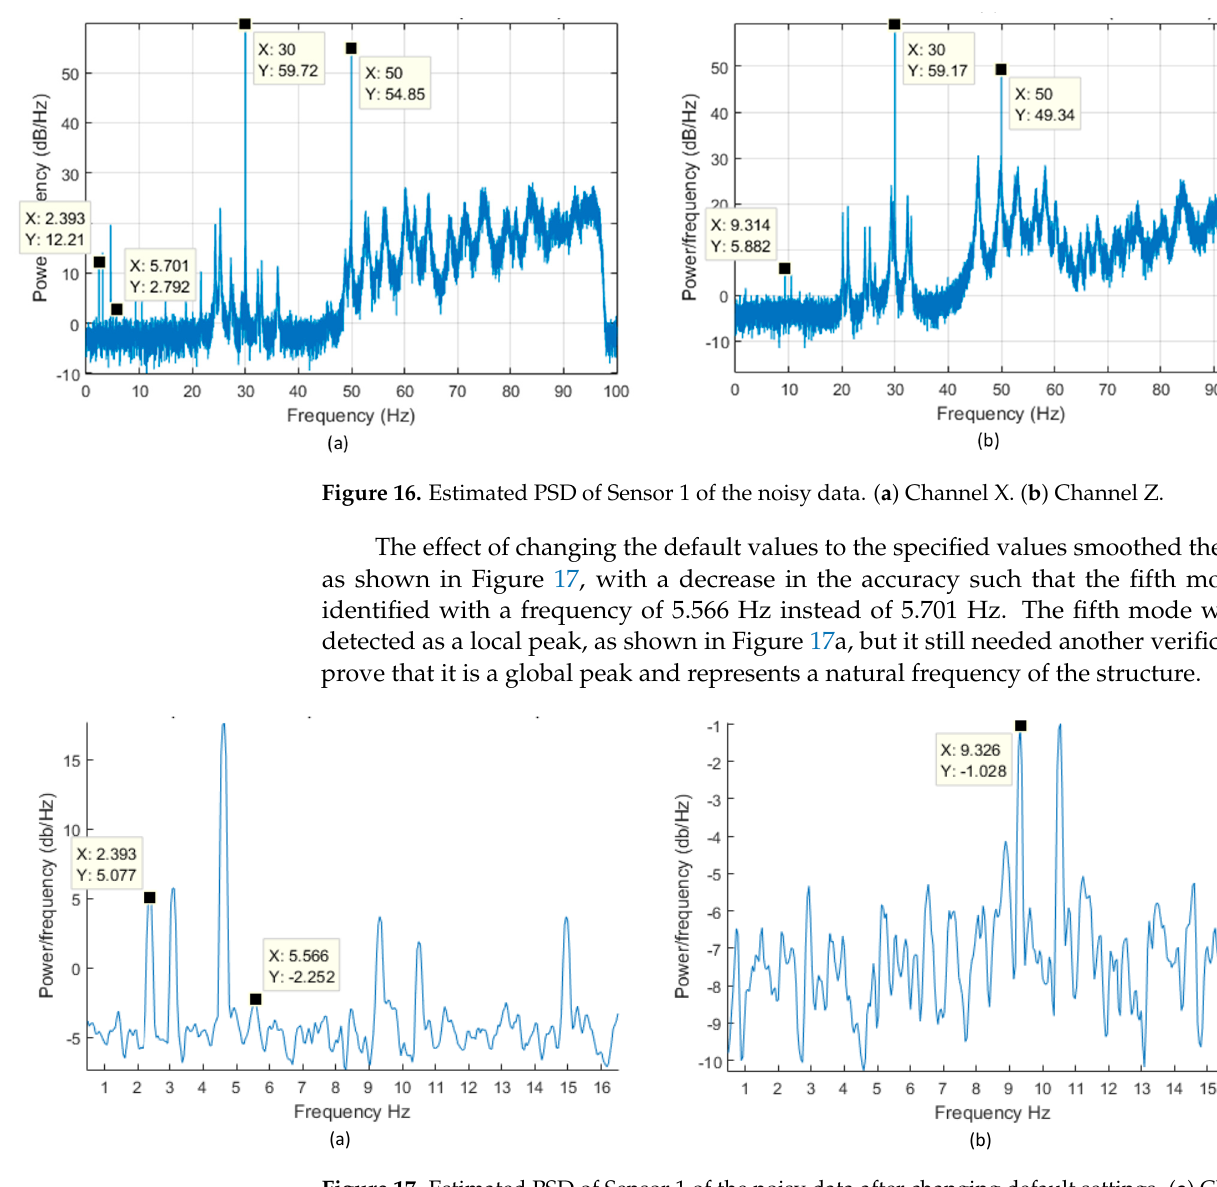
Figure 17. Estimated PSD of Sensor 1 of the noisy data after changing default settings. ( a ) Channel X. ( b ) Channel Z.